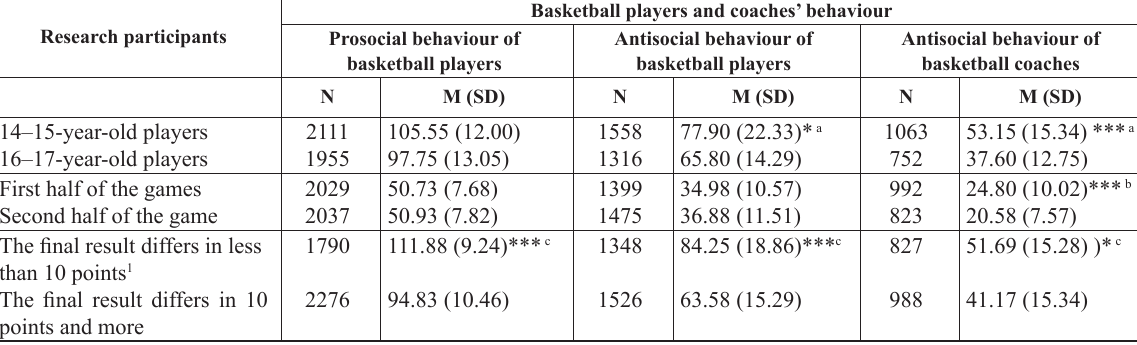
Notes. Sixteen matches ended with a less difference than 10 points, and 24 matches – 10 points and more. The absolute values show the total number of registered actions in all matches observed. a – statistically significant difference comparing behaviours of players of different age and their coaches who trained them; b – statistically significant difference comparing behaviours of players and their coaches in the first and second halves of the game; c – statistically significant difference comparing behaviours of players and their coaches during the game despite their final result. * – p < 0.05; *** – p <